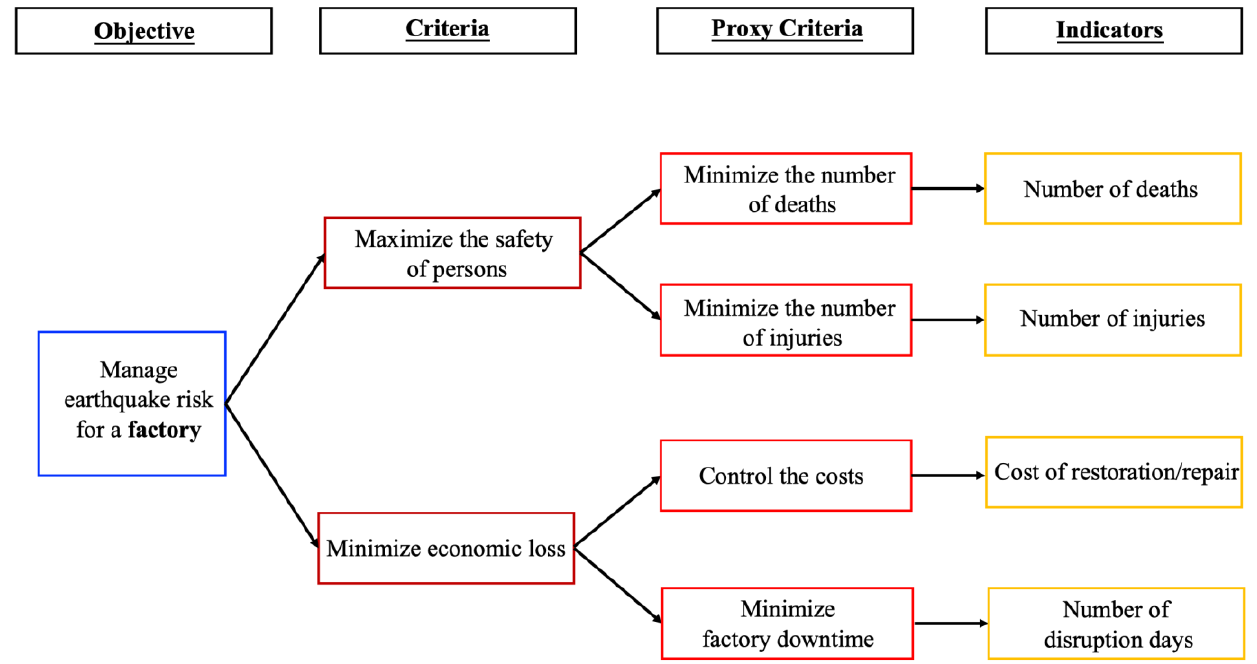
Figure 11. Suggested decision framework for the end-user (i.e., a factory in this case) to determine whether to issue an alert after an earthquake is detected.